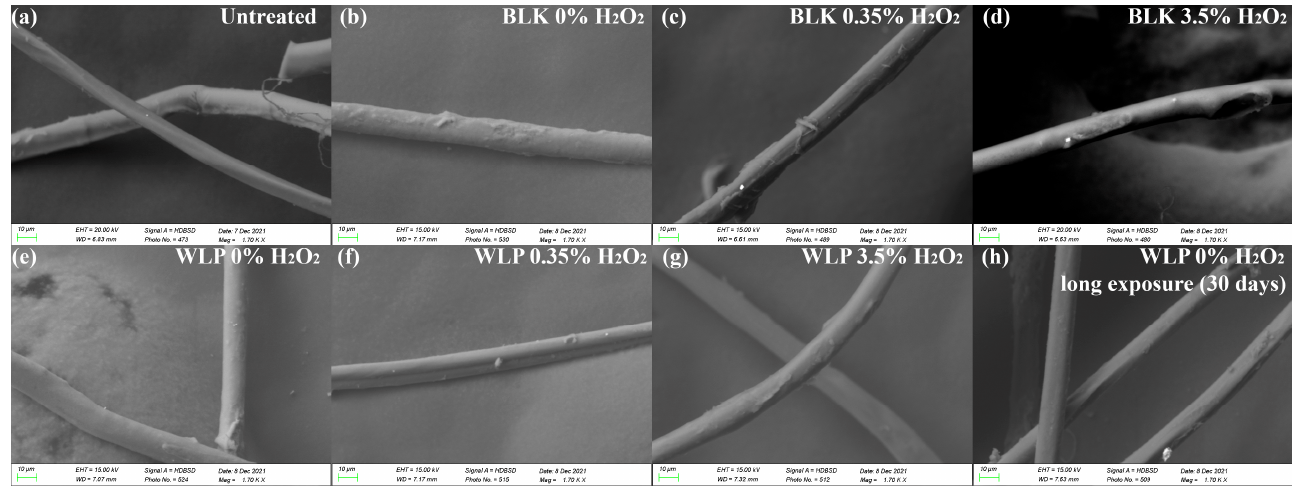
Figure 7. Micrographs of fibers before and after treatment with ( a ) untreated sample, ( b ) BLK 0% of H 2 O 2 , ( c ) BLK 0.35% of H 2 O 2 , ( d ) BLK 3.5% of H 2 O 2 , ( e ) WLP 0% of H 2 O 2 , ( f ) WLP 0.35% of H 2 O 2 , ( g )